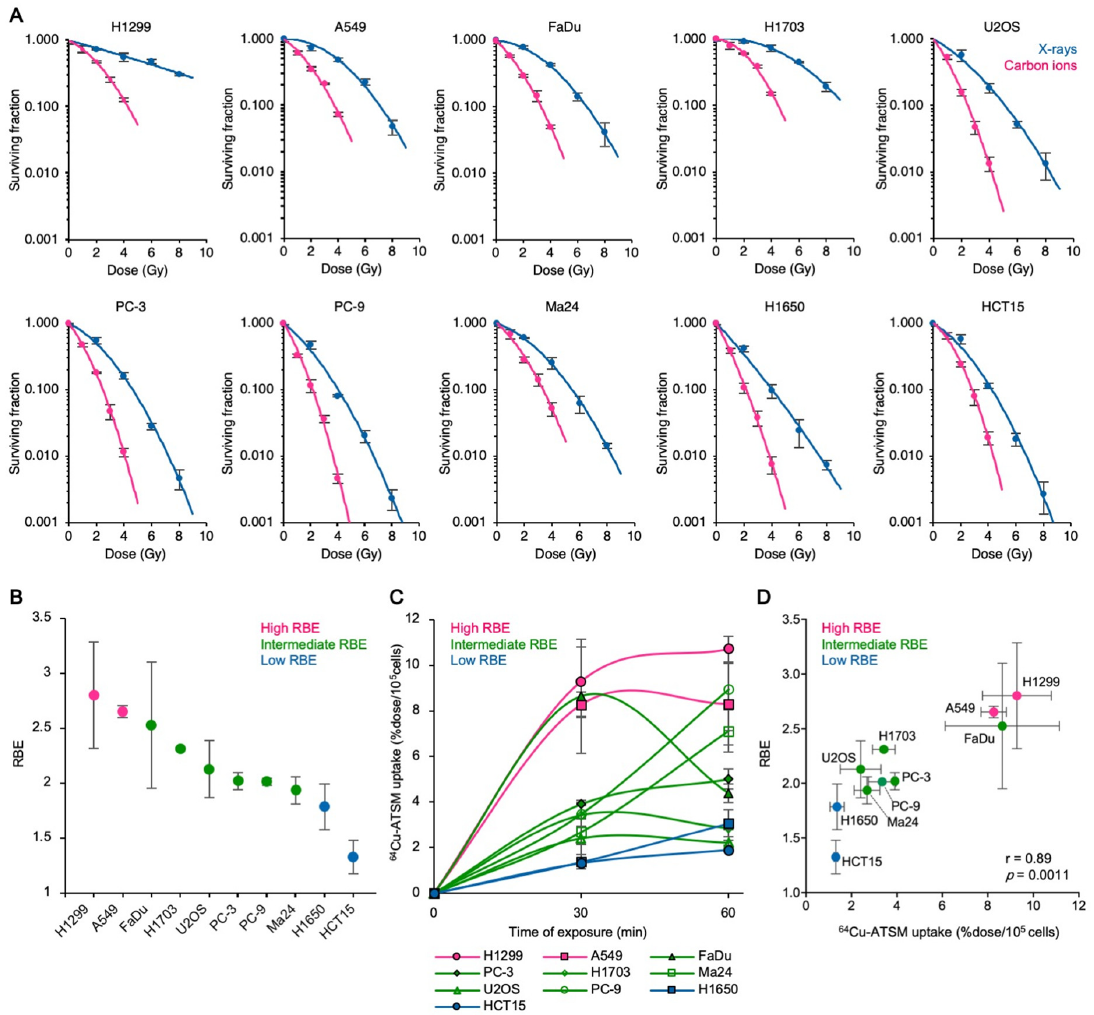
Figure 1. The carbon ion RBE correlates with 64 Cu-ATSM uptake in vitro. ( A ) Sensitivity of various human cancer cell lines to X-rays or to carbon ions, as assessed in clonogenic assays (mean ± SD; n = 3). ( B ) RBE of carbon ions at D 50 (i.e., the dose that provides 50% survival) was calculated from the data in A (mean ± SD; n = 3). ( C ) Intracellular 64 Cu-ATSM uptake by cancer cell lines (mean ± SD; n = 3). ( D ) Correlation between RBE and 64 Cu-ATSM uptake (mean ± SD; n = 3). Data presented in ( B , C ) (30 min) were used for correlation analysis. The p values and correlation coefficients ( r ) calculated using Spearman’s rank test are